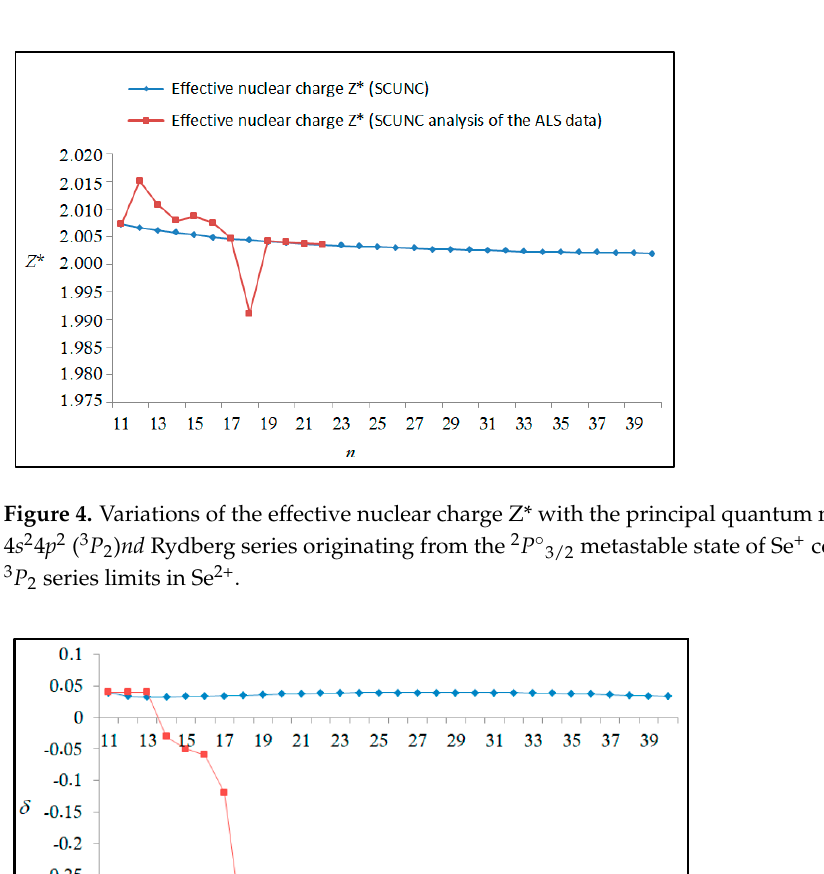
Figure 3. Variations of the quantum defect ( δ ) with the principal quantum number n for the 4 s 2 4 p 2 ( 3 P 2 ) nd Rydberg series originating from the 2 P ° 3/2 metastable state of Se + converging to the 3 P 2 series limits in Se 2+ .